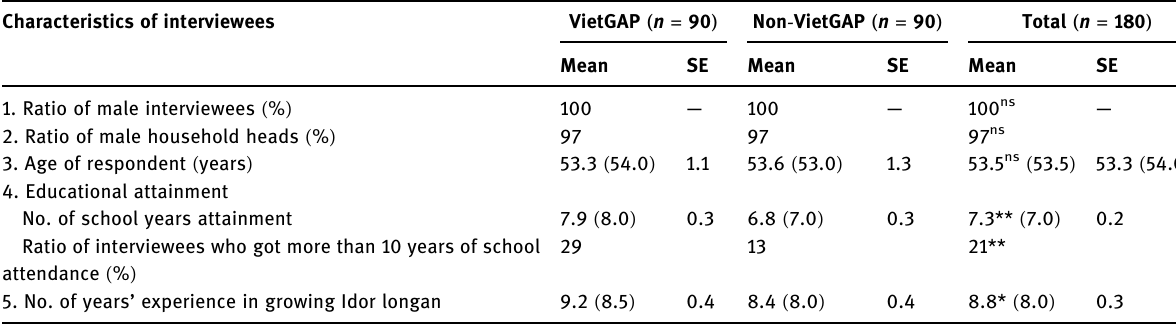
Table 1: Characteristics of interviewees Characteristics of